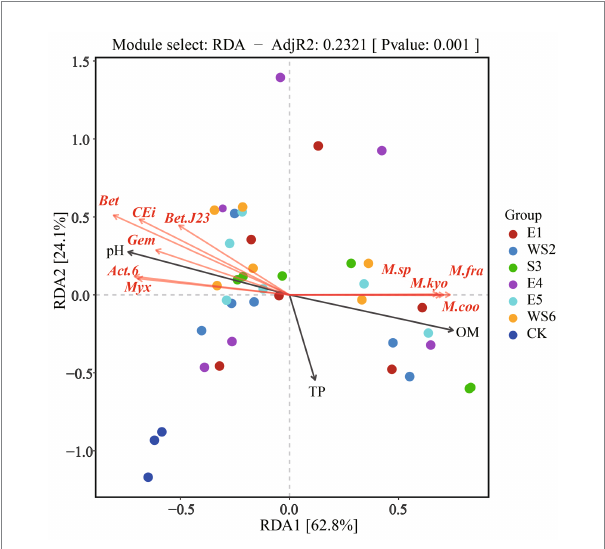
FIGURE 5 RDA analysis between microbial community and soil properties. Bet ,